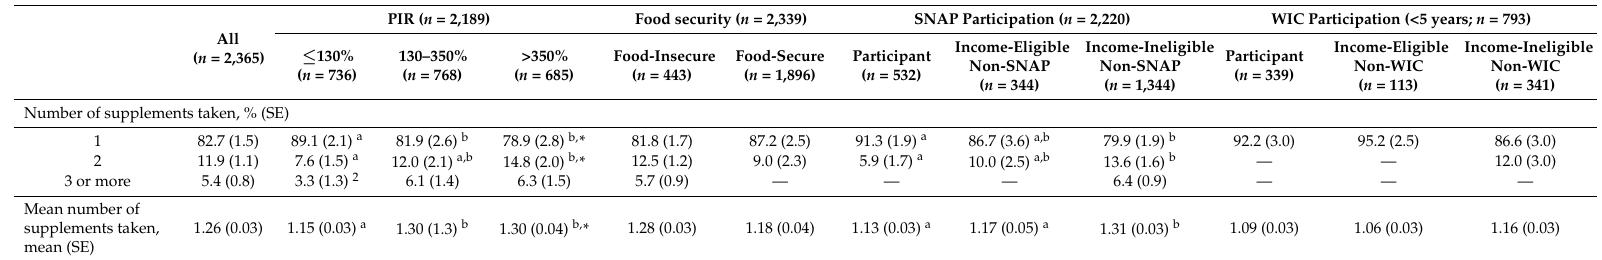
Table 3. Estimated percentage distribution and mean number of any dietary supplement taken by U.S. children ( ≤ 18 years) in a 30-day period by economic indicators, NHANES 2011–2014 1,2 .